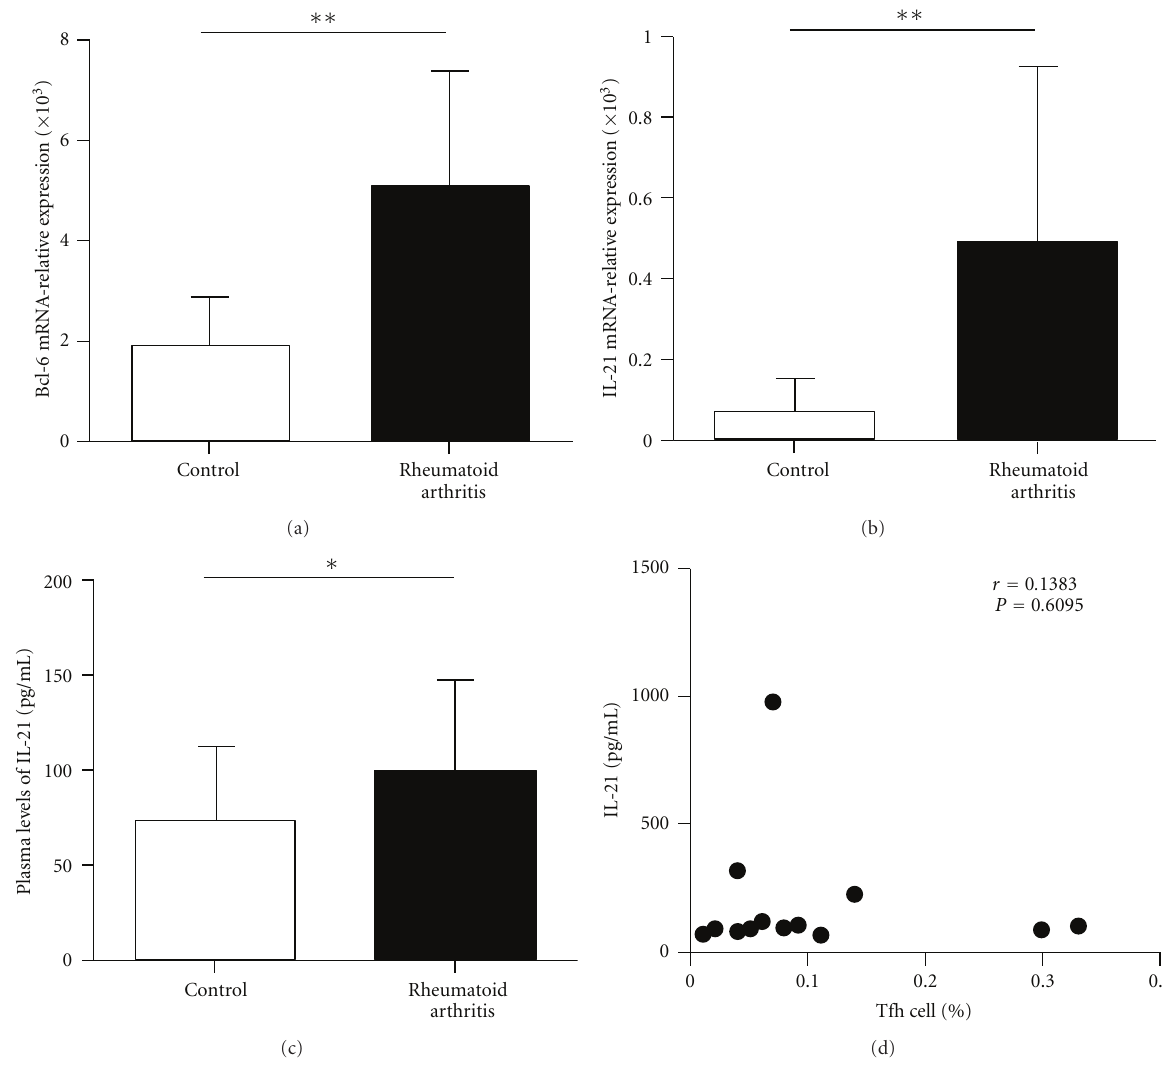
Figure 3: Increased Bcl-6 mRNA, IL-21 mRNA expression, and plasma IL-21 concentration in RA patients. (a) Detection of Bcl-6 mRNA expression in RA patients and healthy controls. Bcl-6 mRNA was estimated by real-time RT-PCR. Data correspond to the mean ± SD of 7 RA patients and 7 healthy controls ( ∗∗ P < 0 . 01). (b) Detection of IL-21 mRNA expression in RA patients and healthy controls. IL-21 mRNA was estimated by real-time RT-PCR. Data correspond to the mean ± SD of 7 RA patients and 7 healthy controls ( ∗∗ P < 0 . 01). (c) Plasma IL-21 concentration in RA patients ( n = 35) and healthy controls ( n = 29) ( ∗ P < 0 . 05). (d) Relationship between plasma IL-21 concentration